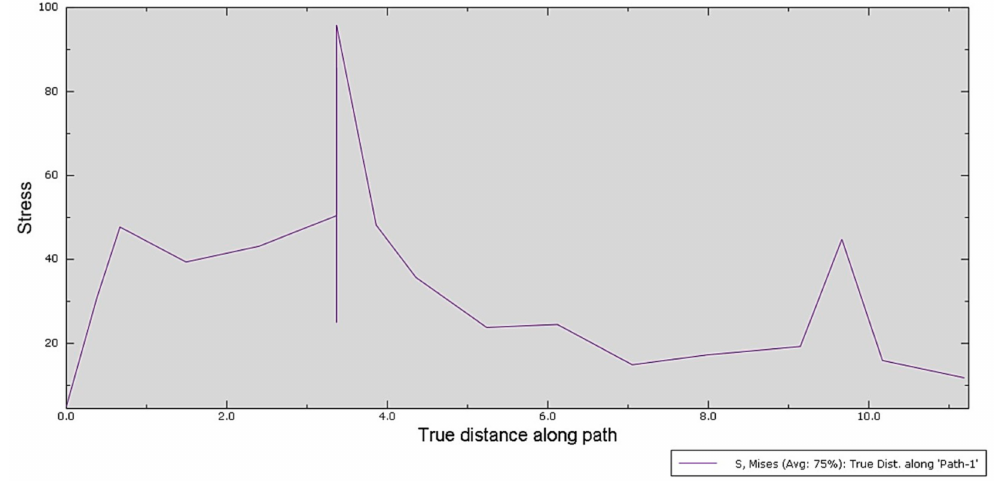
Figure 7. Stress variation along the critical zone, Path nodes ( x -axis) and the Von Mises stress field output ( y